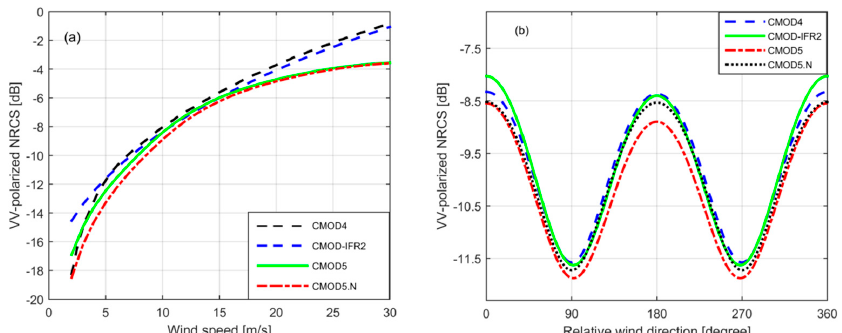
Figure 3. ( a ) Dependence of VV-polarized normalized radar cross section (NRCS) from CMOD geophysical model functions (GMFs) versus ocean surface wind speeds (OSWSs) at a local incidence angle of 30° and wind direction relative radar look angle of 180°. ( b ) Dependence of VV-polarized NRCS from CMOD GMFs versus wind direction relative radar look angle at a local incidence angle of 30° and wind speed of 10 m/s.